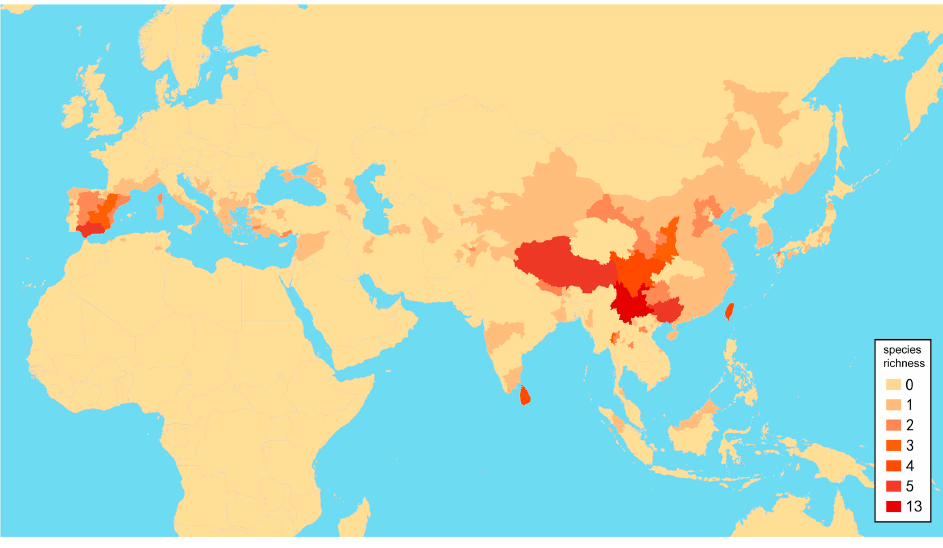
Figure 18. Pattern of species richness of the genus Dilar .